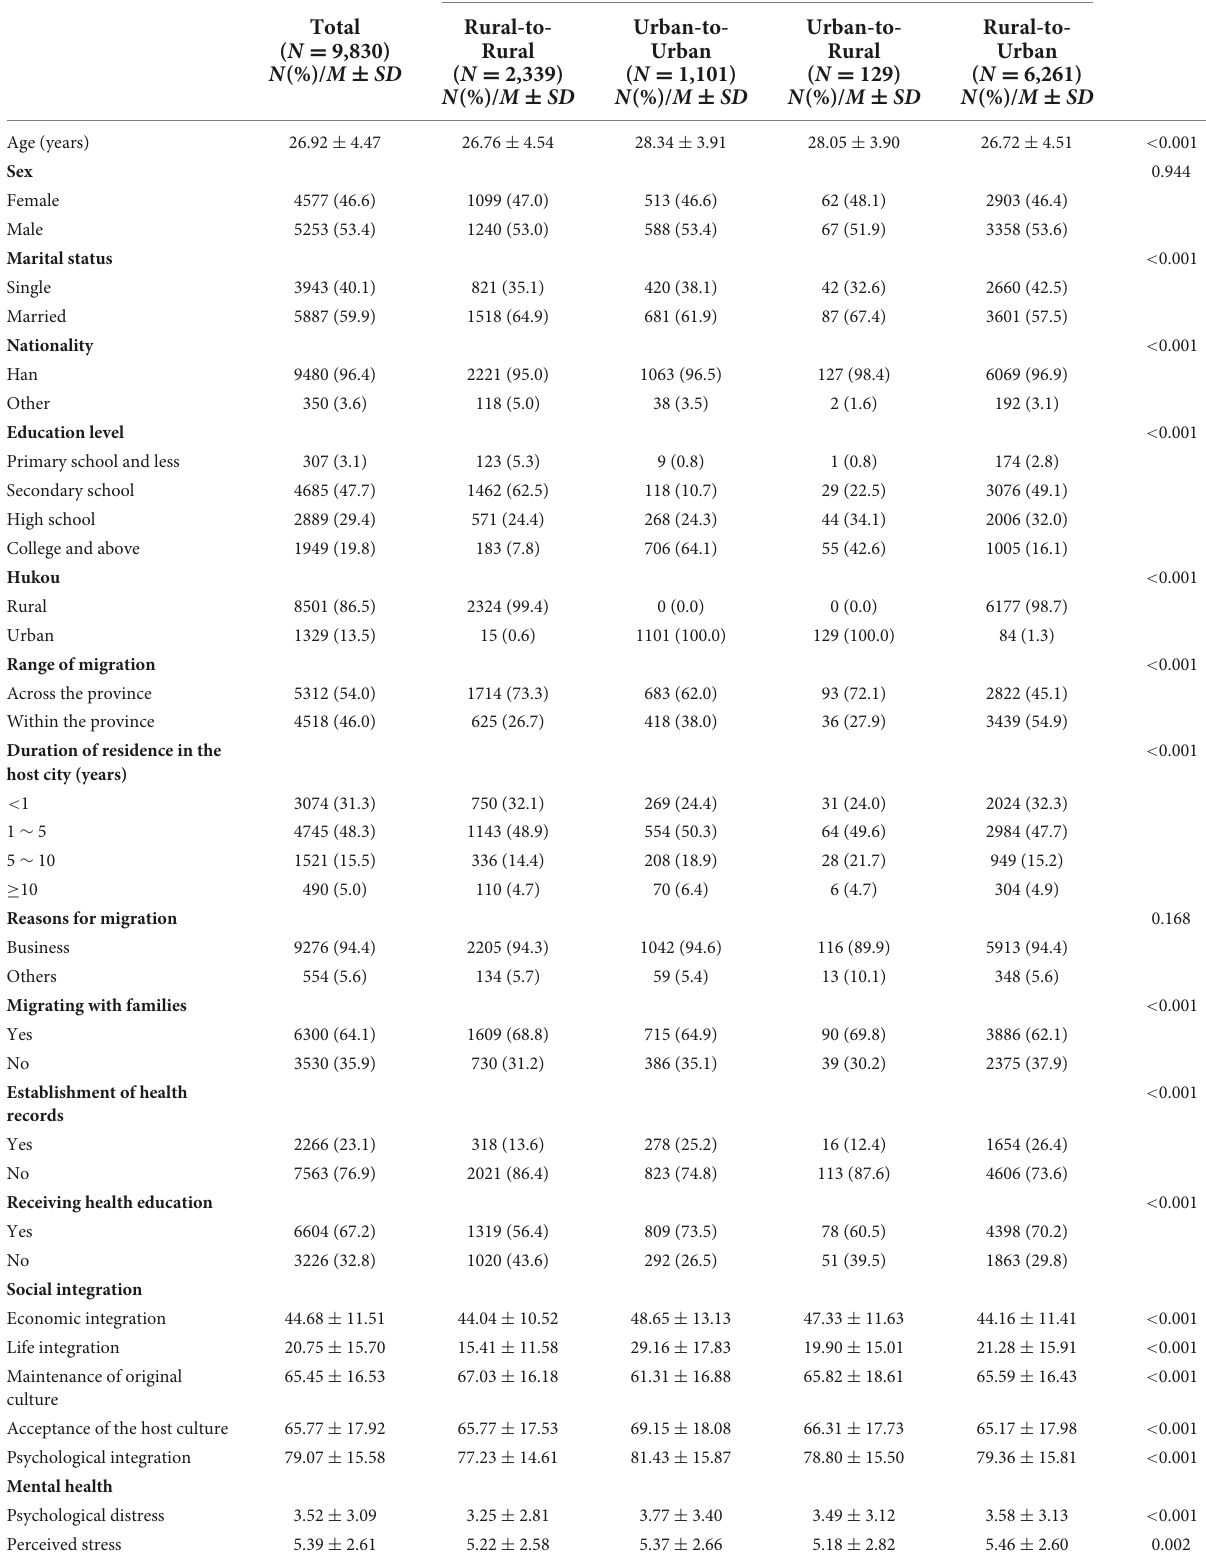
TABLE 1 Characteristics of 9,830 new-generation migrants from Internal Migrant Dynamic Monitoring Survey in China, 2014. Variables Migration